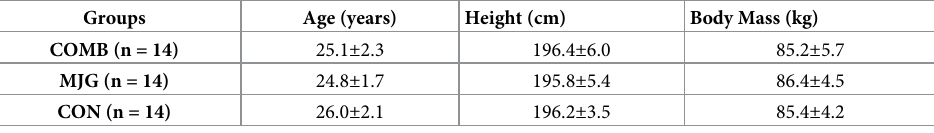
to wear the same sports equipments and the same time of the testing was respected all over the experimental period to minimize any effects of diurnal variations [24]. Throughout the experi- mental period, the MJG, COMB and CON groups completed the same training volume (~ 90 minutes per session) in which training sessions started with a 15-minute warm-up followed by technical and tactical drills based on basic basketball movements and a simulated game at the end of every session [7] (Table 1). Table 2. Anthropometric characteristics of the participants.